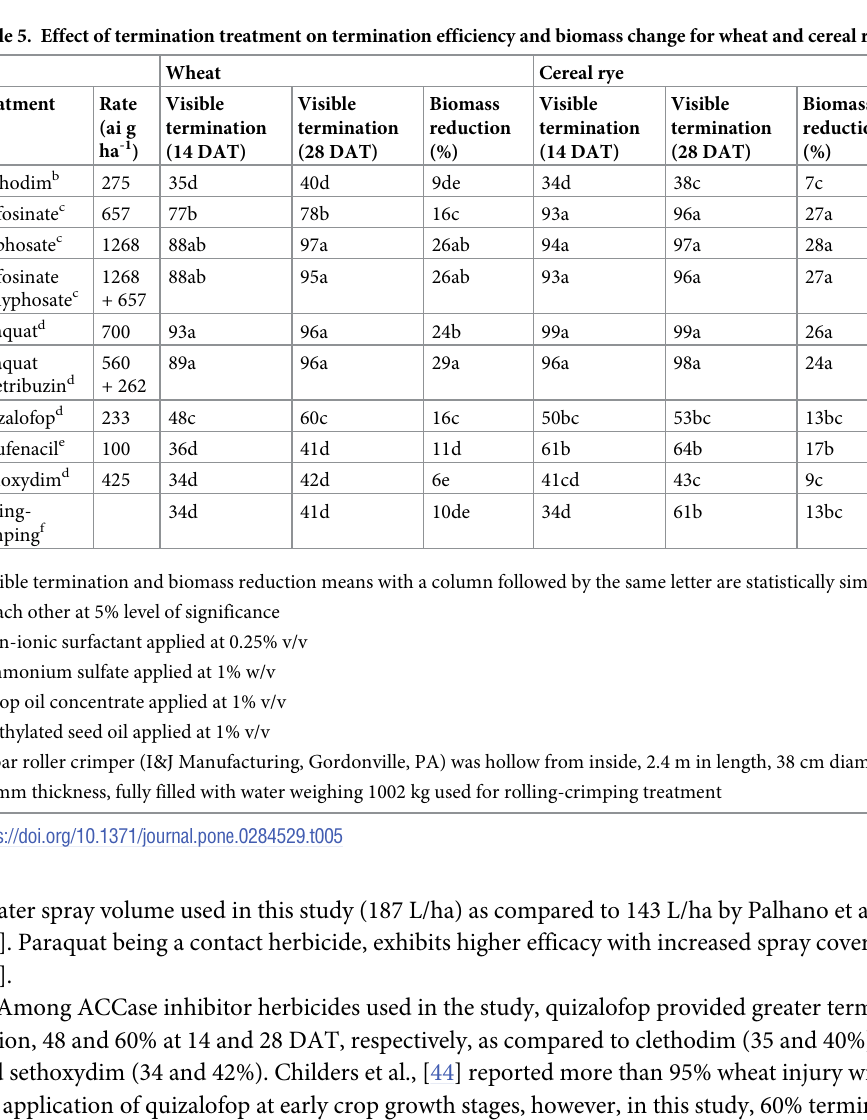
Table 5. Effect of termination treatment on termination efficiency and biomass change for wheat and cereal rye a .